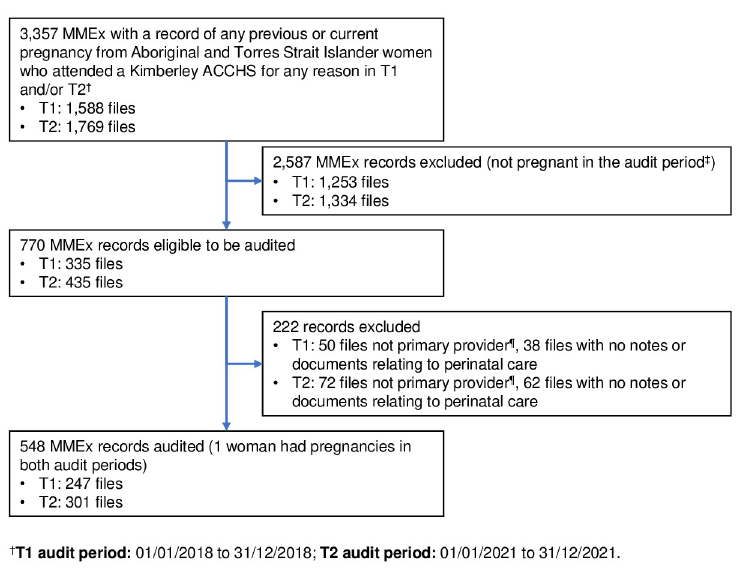
Fig 1. Flow chart for inclusion in the KMMS audit at timepoint 1 and timepoint